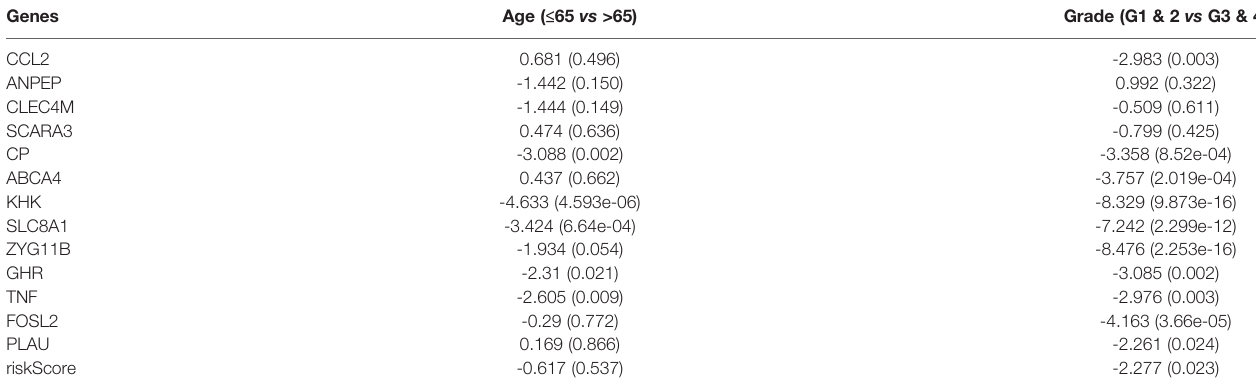
TABLE 4 | Clinical correlation analysis.